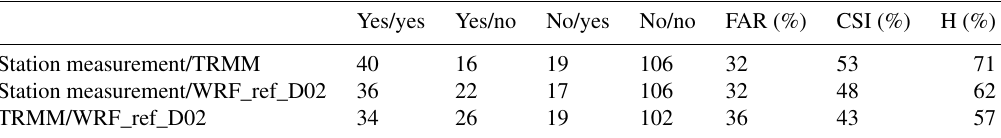
Figure 9. Diurnal cycle of the mixing layer heights (m) as a boxplot (showing the median, the upper and lower quantiles) as diagnosed by the WRF model (WRF_ref_D02) and as determined from ceilometer measurement data at the Bode site for the period of January–February (a) and March–June 2013 (b) . Table 6. Number of observed and forecast precipitation days (days with sum of precipitation > 0.5mmday − 1 ) during the period of January– June 2013. Yes/yes – both data sets have a precipitation day at the same time; yes/no – first data set has a precipitation day, second does not; no/yes – first has no precipitation day, second does; no/no – both do not have a precipitation day. FAR – false-alarm ratio, CSI – critical success index, H – hit ratio.